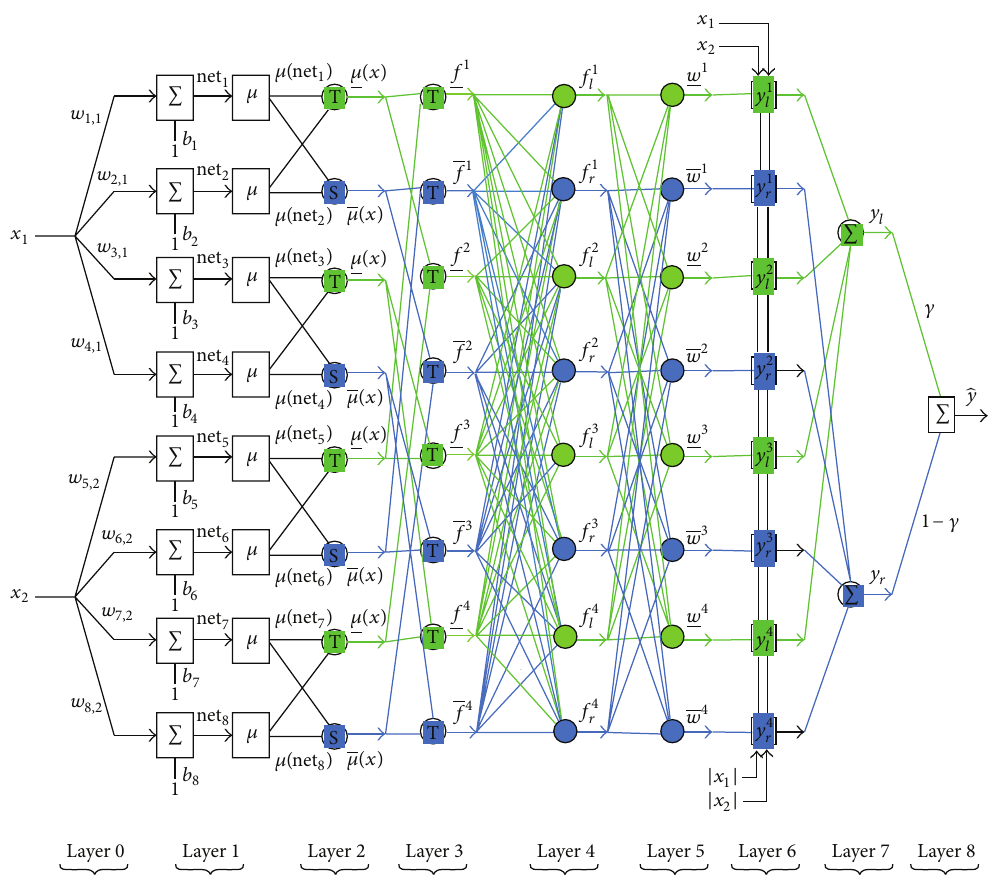
Figure 2: IT2FNN-3 architecture.